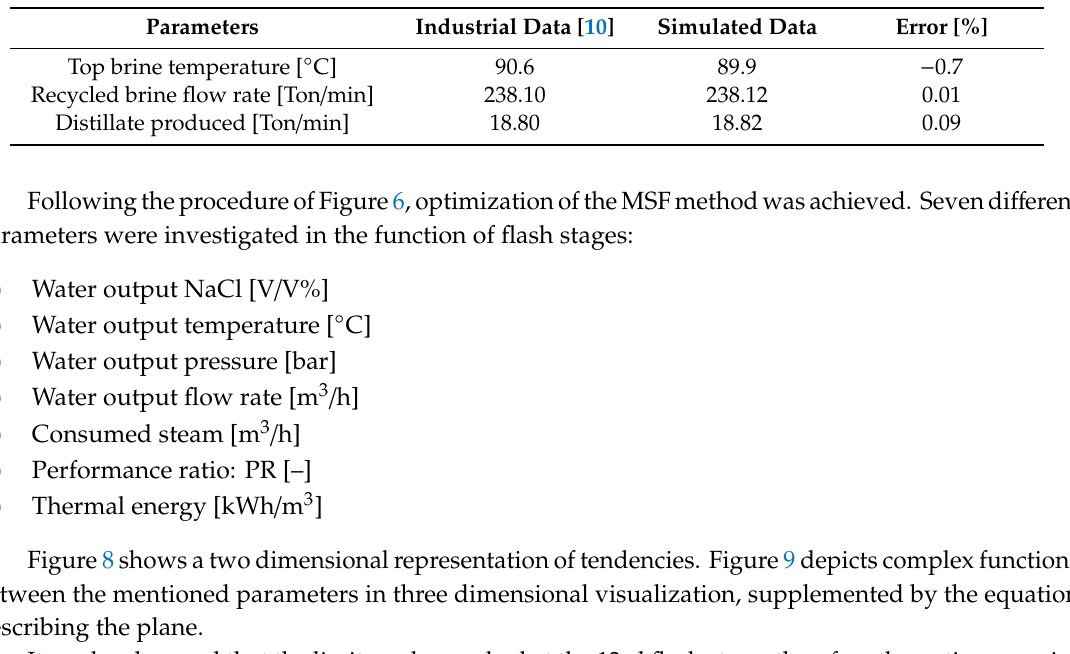
Table 4. Comparison of AZ-ZOUR South MSF desalination plant results and ChemCAD calculations.